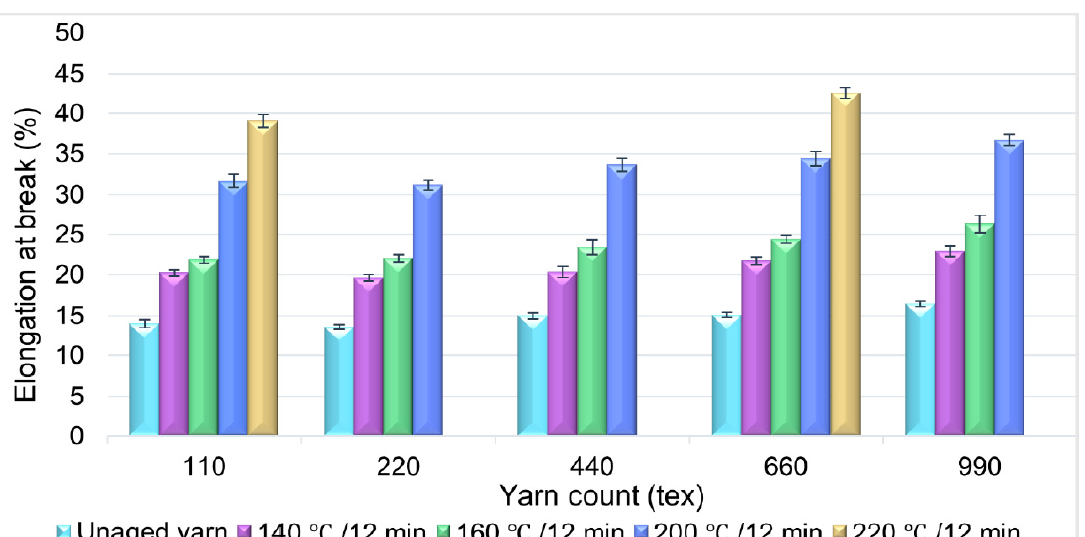
Figure 6. Effect of aging temperature on the percentage elongation of HT polyester